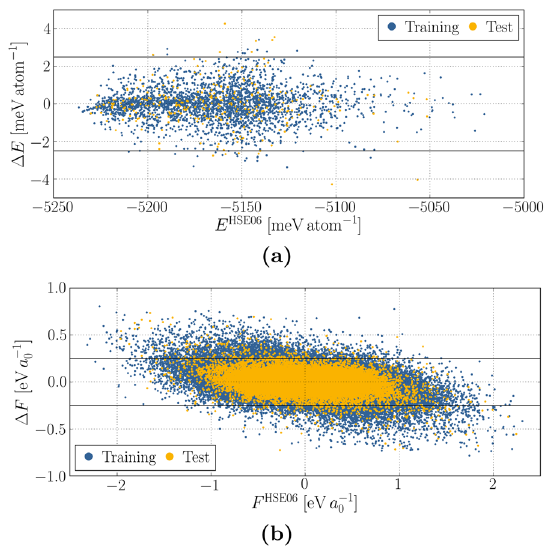
Fig. 1 Accuracy of the mHDNNP. a Energy errors Δ E = E mHDNNP − E HSE06 as a function of the reference energy E HSE06 and b force component errors Δ F = F mHDNNP − F HSE06 as a function of the reference Fig. 2 Different magnetic orders of MnO. a Rhombohedral MnO force components F HSE06 . global minimum structure with AFM-II order, b magnetic order degenerate to the cubic AFM-II order, c AFM-I order, and d FM order of MnO. Small red balls represent O atoms, large violet ones Mn atoms with spin-up, and large blue ones Mn atoms with spin- Table 1. Details of the mHDNNP fi t. down 95 . Different perspectives of the magnetic orders a and b are shown in the Supplementary Fig. Training set Test set